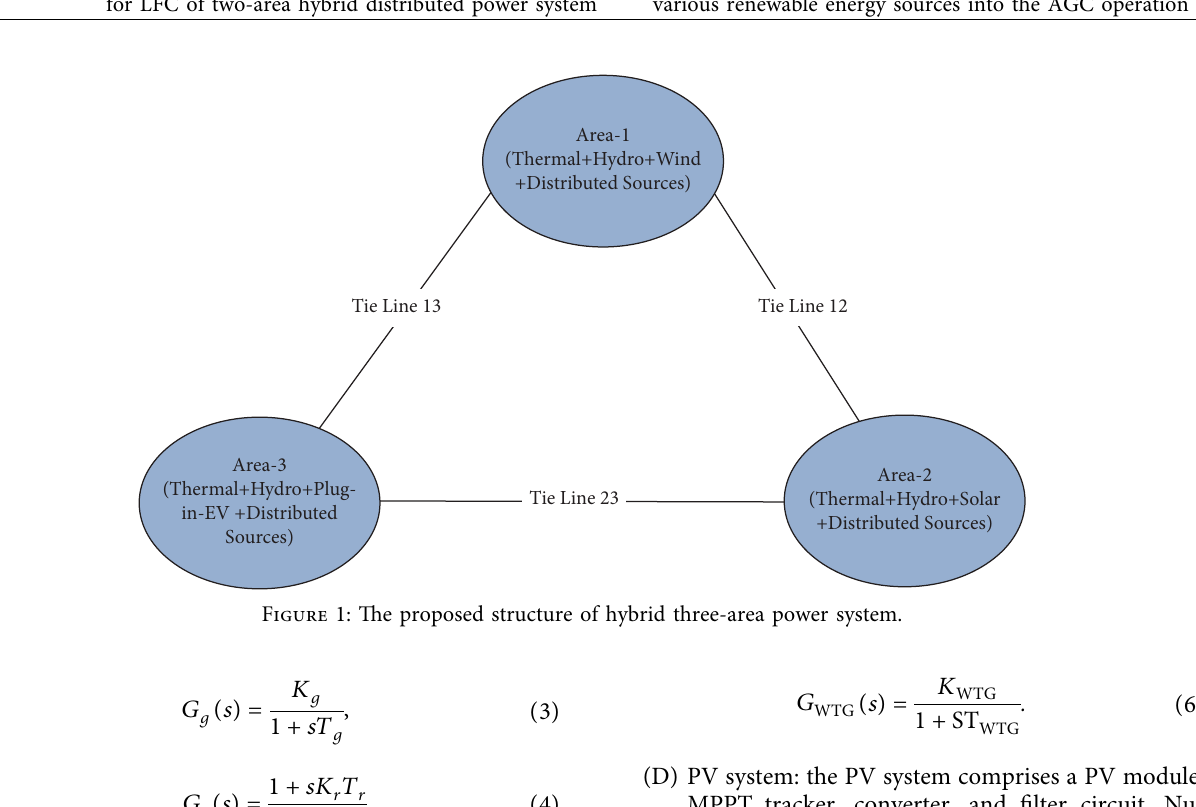
Figure 1: Te proposed structure of hybrid three-area power